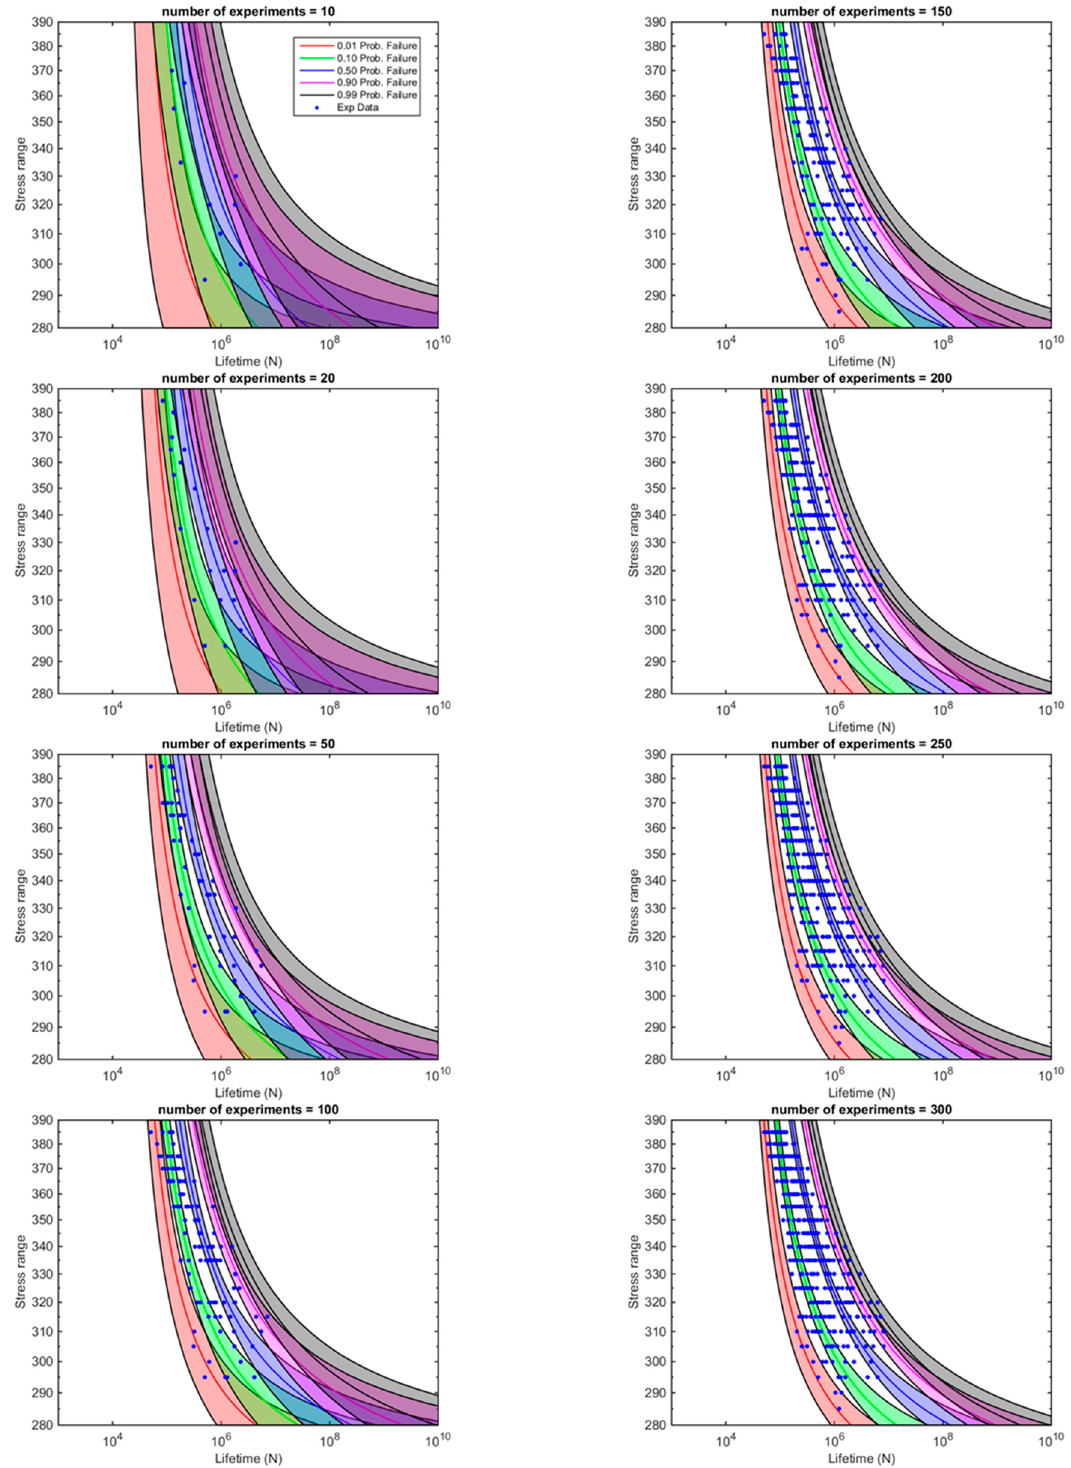
Figure 9. Evolution of the whole p-S-N field (S-N percentile curves and confidence intervals) with the number of tests implied in the fitting process.